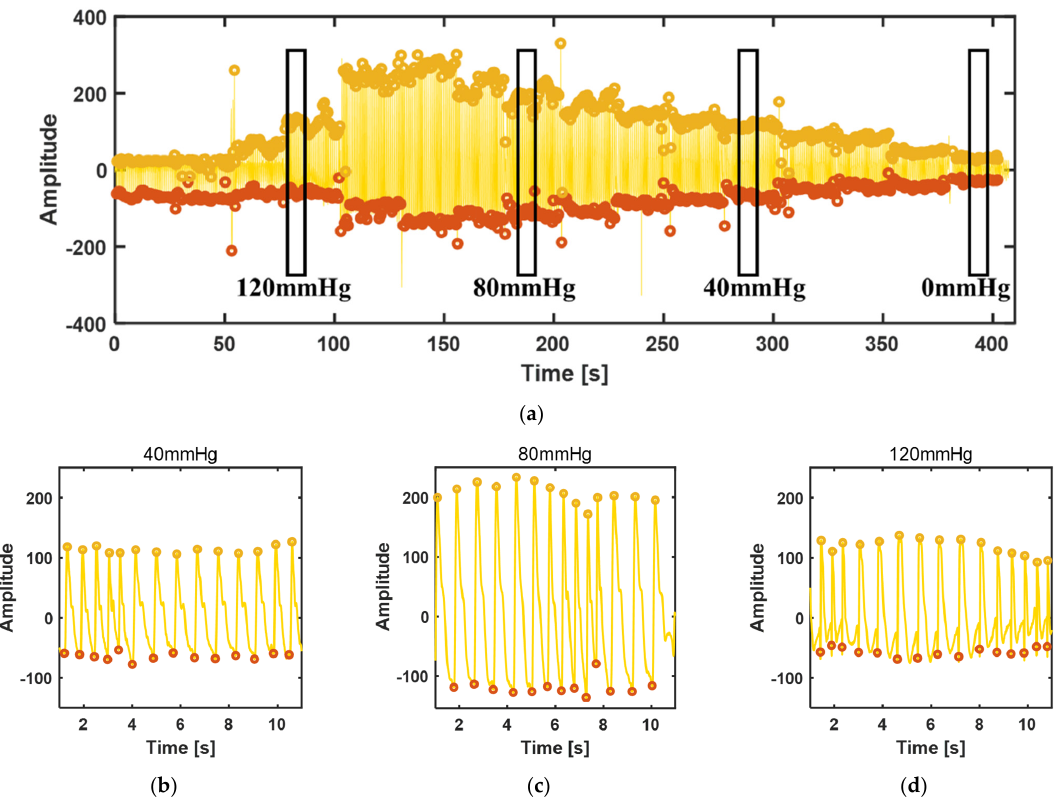
Figure 7. Comparison of pulse waveform under three adhesion conditions at 0 mmHg pressure: ( a ) Direct measurement without adhesive; ( b ) With 3M strong double-sided adhesive; ( c ) With the bi- omimetic fusion structure adhesion.